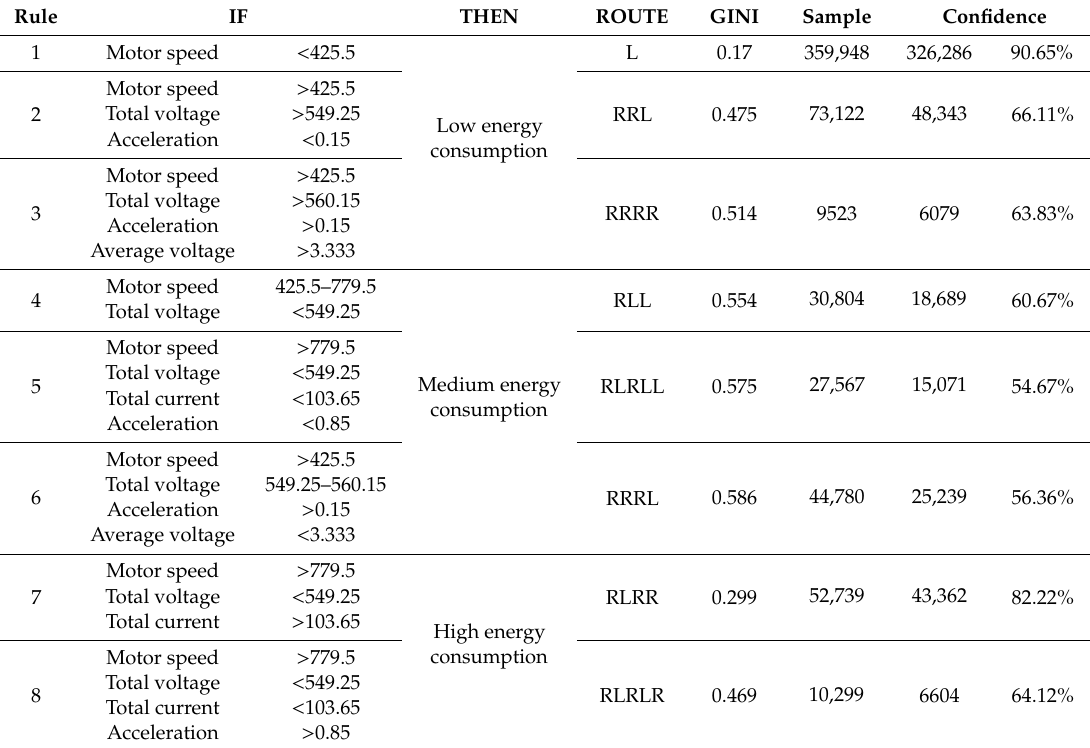
Table 7. Classification rules of the optimal decision tree